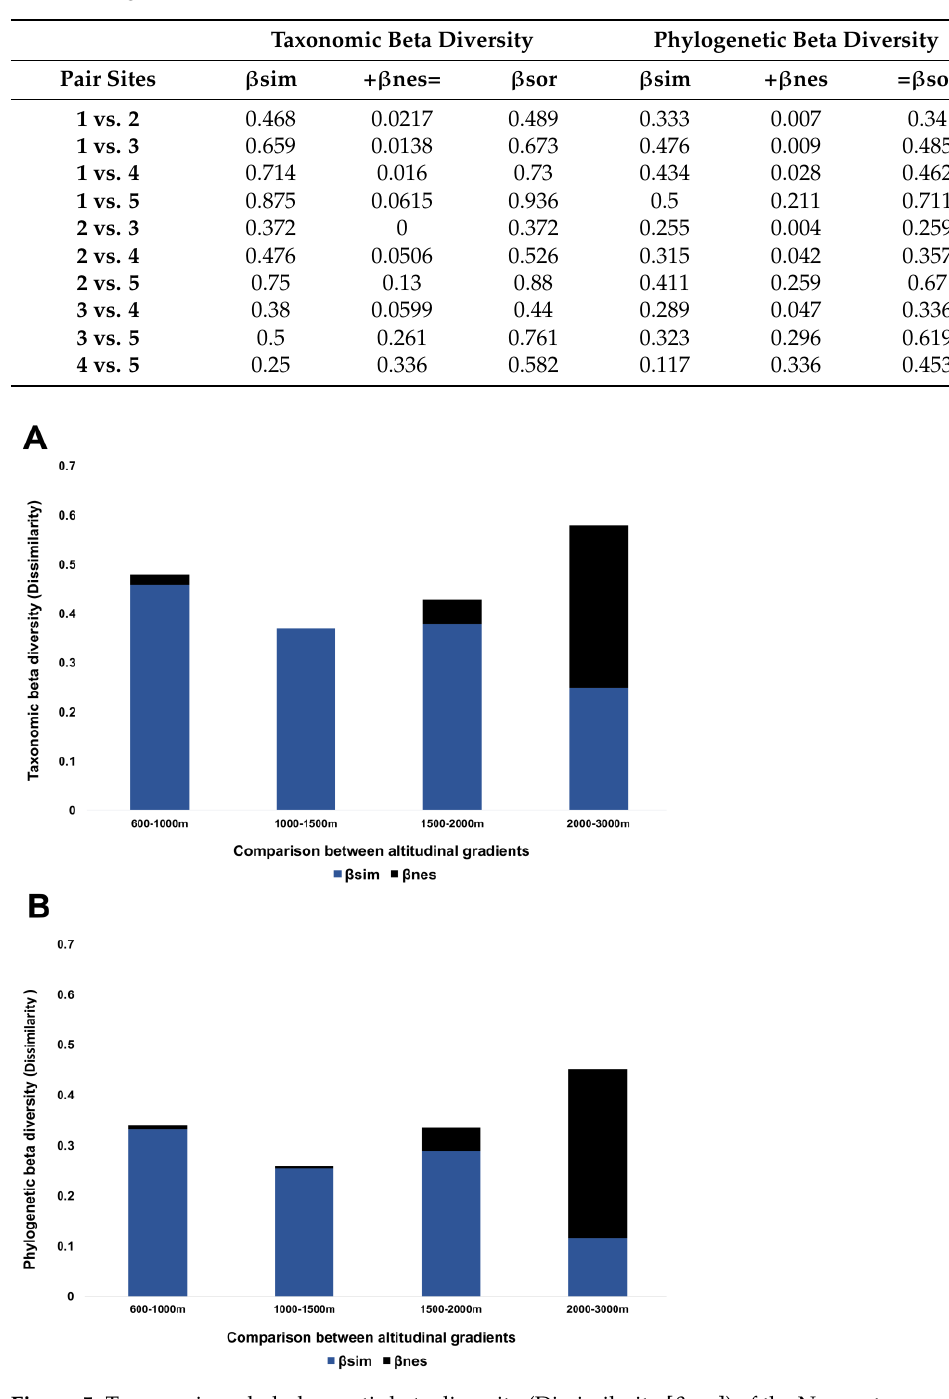
Figure 5. Taxonomic and phylogenetic beta diversity (Dissimilarity [βsor]) of the Neuroptera community of the Tacaná Volcano with the criterion of pairs of sites, with each of its components, turnover (βsim), and nestedness (βnes). ( A ) Taxonomic beta diversity across the altitude gradient of the Tacaná Volcano obtained using species incidence. ( B ) Phylogenetic beta diversity through the altitudinal gradient of the Tacaná Volcano using taxa incidence.